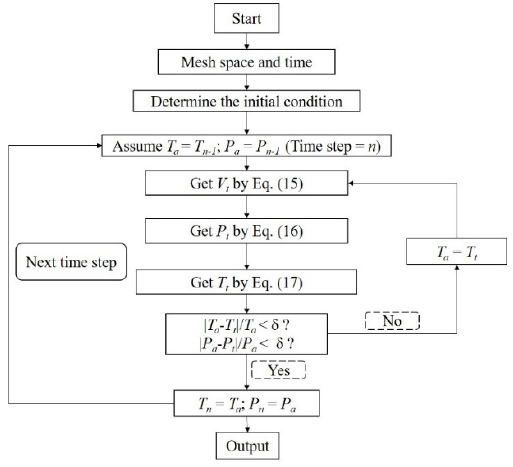
Figure 2. The calculation process.